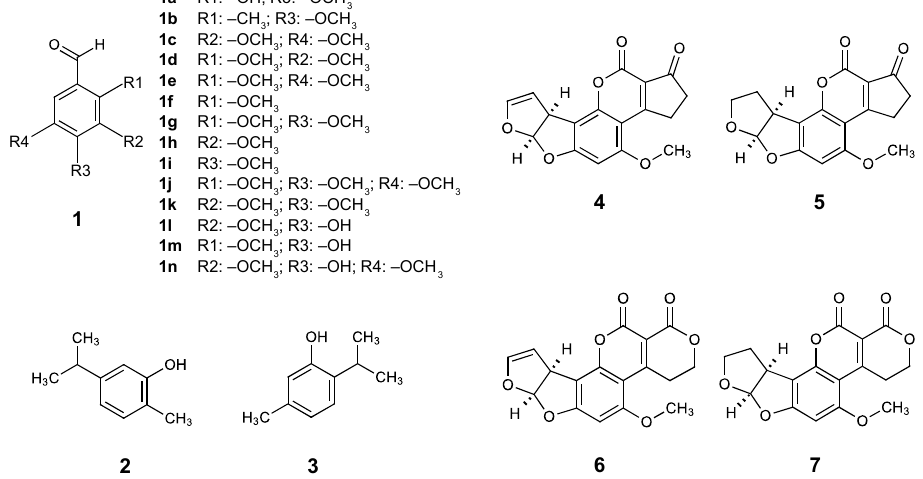
Figure 1. Structures of benzo derivatives, carvacrol, thymol, and aflatoxins used/detected in this study. ( 1 ) Benzaldehyde and derivatives: ( 1a ) 2-Hydroxy-4-methoxybenzaldehyde, ( 1b )